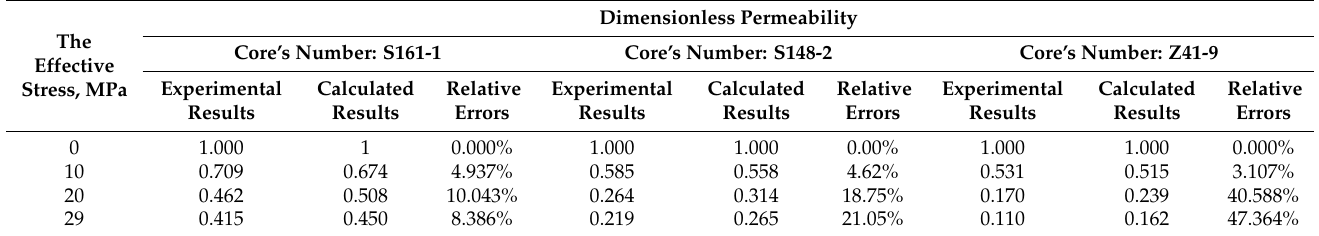
Table 4. The comparison between the dimensionless permeability calculated by the proposed model and that found in experiments by Liu et al.